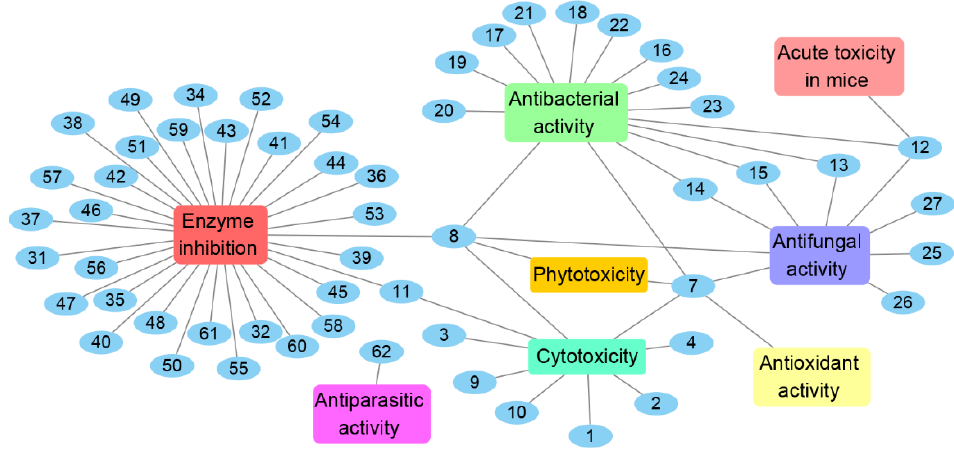
Figure 14. Bioactivities of natural products isolated from Chrysosporium from 1984 to 2021.